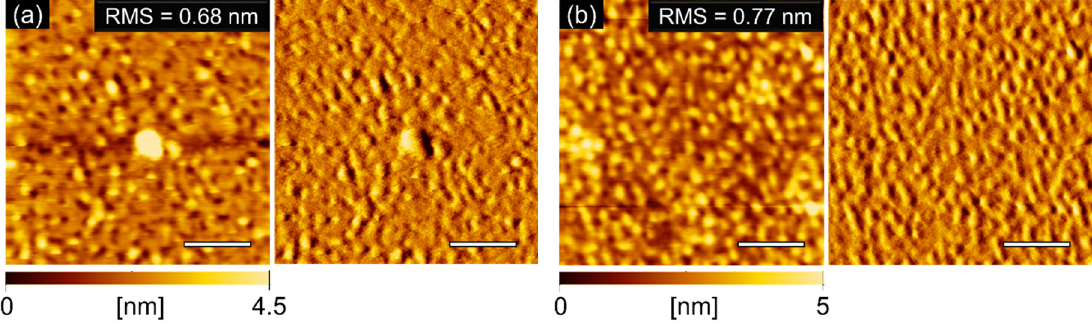
Figure 5. Topographic (left) and error-signal (right) images (2 µ m × 2 µ m) of thin films of C6-DNADT on octyltrichlorosilane (OTS)-modified n + -Si / SiO 2 substrate; ( a ) T anneal = as-deposited and ( b ) T anneal = 100 °C. The scale bar is 500 nm.